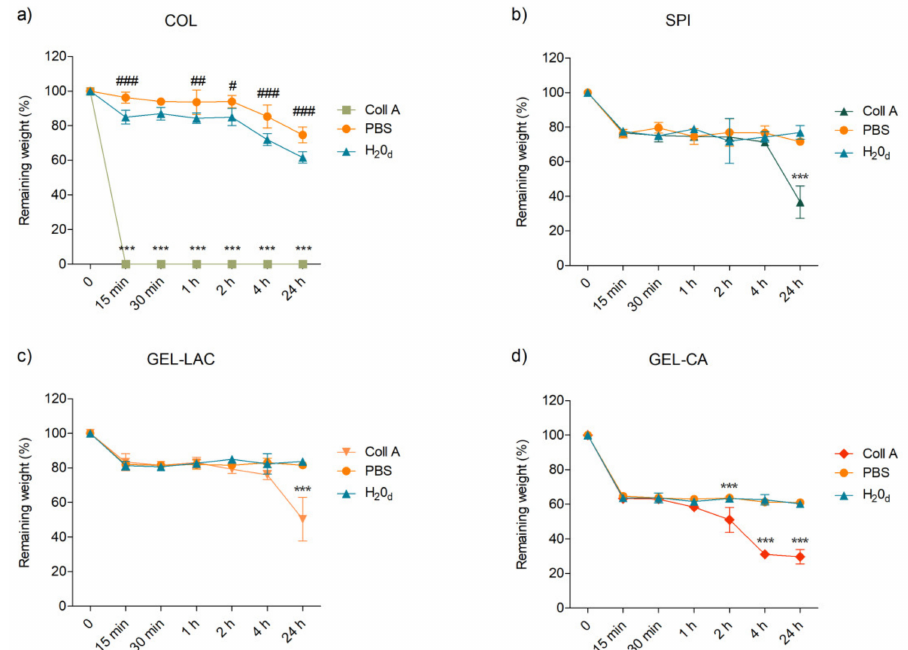
Figure 3. In vitro degradation of the films immersed in 200 ug/mL collagenase A solution or PBS alone at 37 ◦ C over time. Films immersed in distilled water at 37 ◦ C were used as control. (a) represents the degradation profiles of COL films; (b) the degradation profiles of SPI films; (c) the degradation profiles of GEL-LAC films and (d) the degradation profiles of GEL-CA films. Data are reported as means ± SD, and statistically significant differences of films in collagenase A (*) and PBS (#) are reported with respect to those in distilled water. * p < 0.05, ** p < 0.01, *** p < 0.001; # p < 0.05, ## p < 0.01, ### p < 0.001; n =